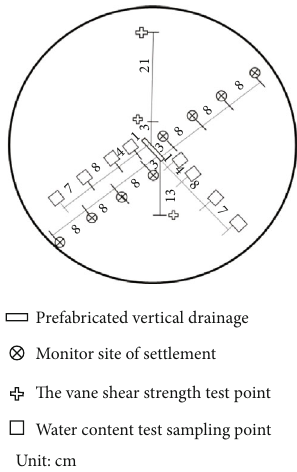
Figure 6: Schematic diagram of test points and sampling points.